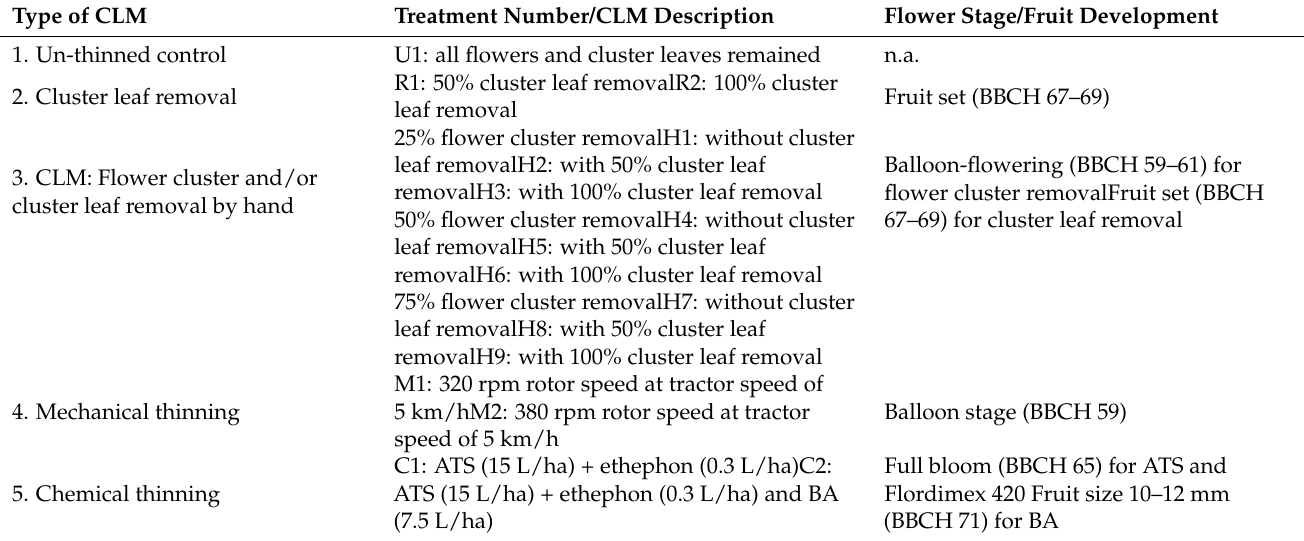
Table 1. Crop load management (CLM) in